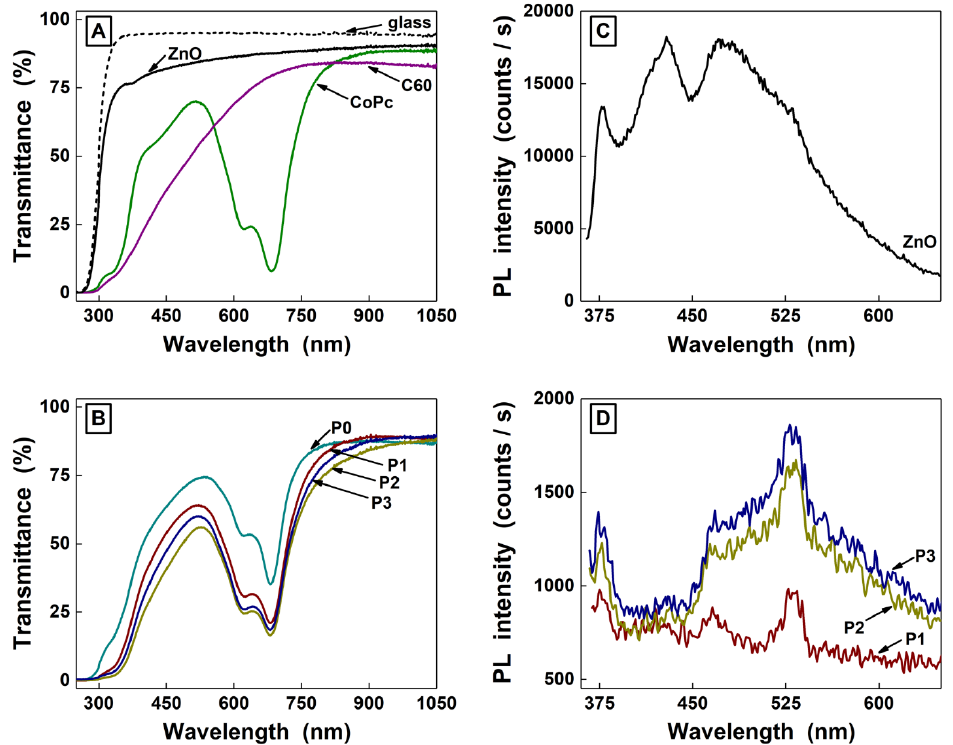
Figure 7. Ultraviolet–visible (UV–Vis) spectra ( A , B ) and PL spectra ( C , D ) of the MAPLE-deposited thin films.